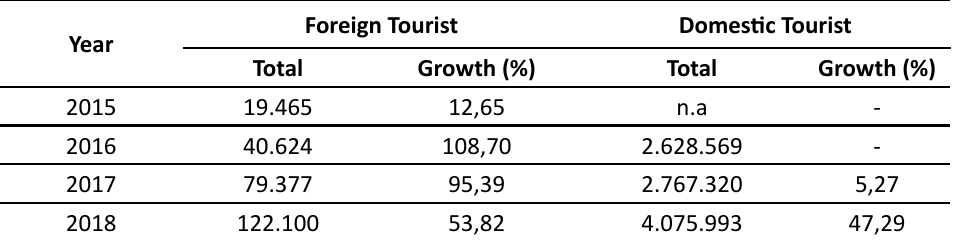
Table 2: Total and Growth of Tourist Arrivals in North Sulawesi, 2015-2018 Foreign Tourist Domestic Tourist Year Total Growth